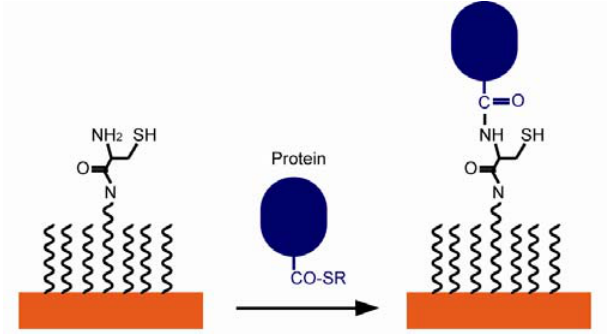
Figure 12. The Cys N-termini of SAM’s reacts with the C-termini of protein through dehydration and forms an amide bond (adapted from